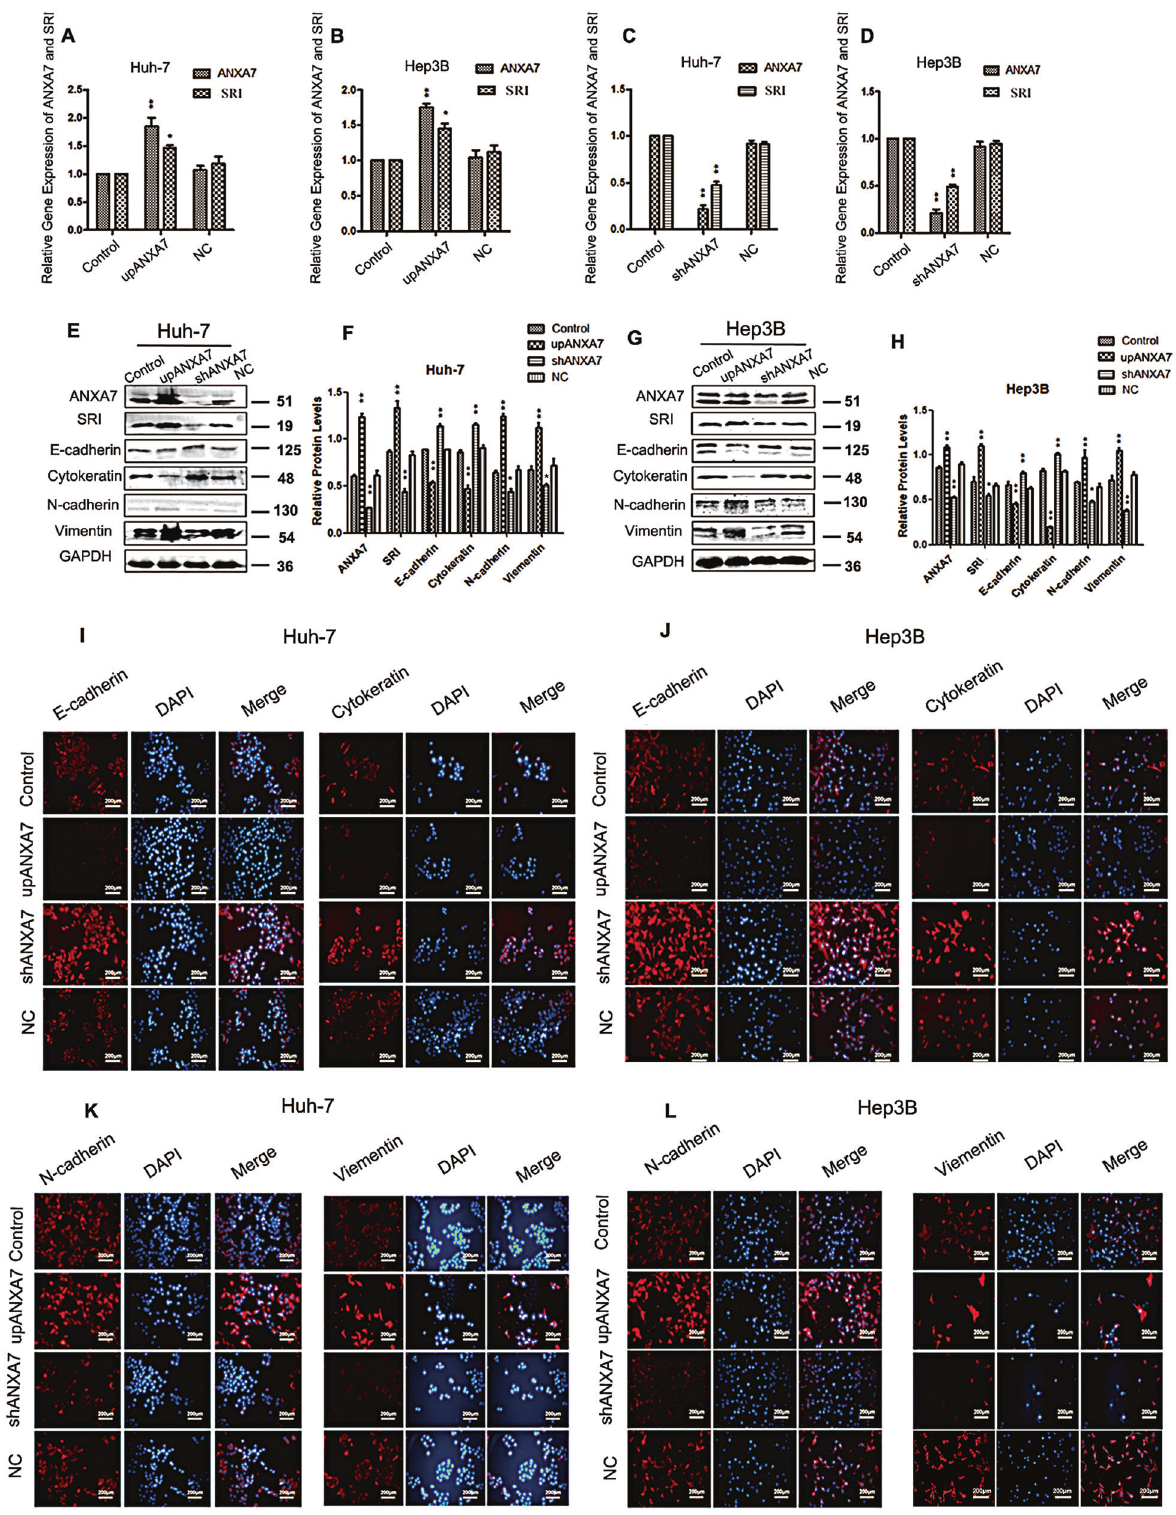
Fig. 3 ANXA7 expression positively regulates SRI expression and affects EMT in HCC cells. A – D Upregulated ANXA7 increased SRI expression and downregulated ANXA7 decreased SRI expression at the mRNA level in Huh-7 and Hep3B cells (** p < 0.01,* p < 0.05). E – H Upregulated ANXA7 increased SRI expression at the protein level and promoted EMT, whereas downregulated ANXA7 decreased SRI expression at the protein level and inhibited EMT in Huh-7 and Hep3B cells (** p < 0.01,* p < 0.05). I – J IF was used to detect E-cadherin and cytokeratin. K , L IF assay was used to detect the N-cadherin and Vimentin in Huh-7/Hep3B cells.